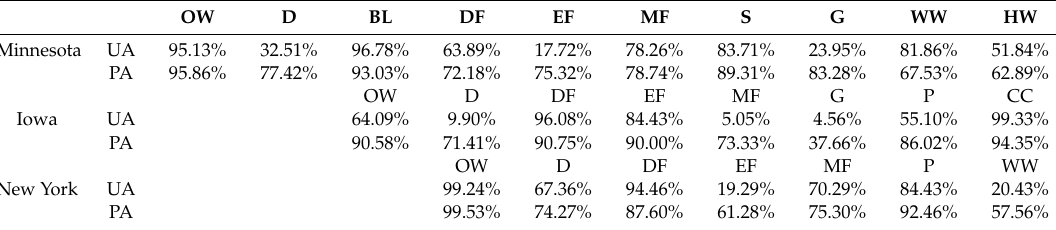
Table 4. Average producer and user accuracies of the classifications derived from original percentiles (see Table 3 for the associated overall accuracies). Ten independent classification experiments in total were carried